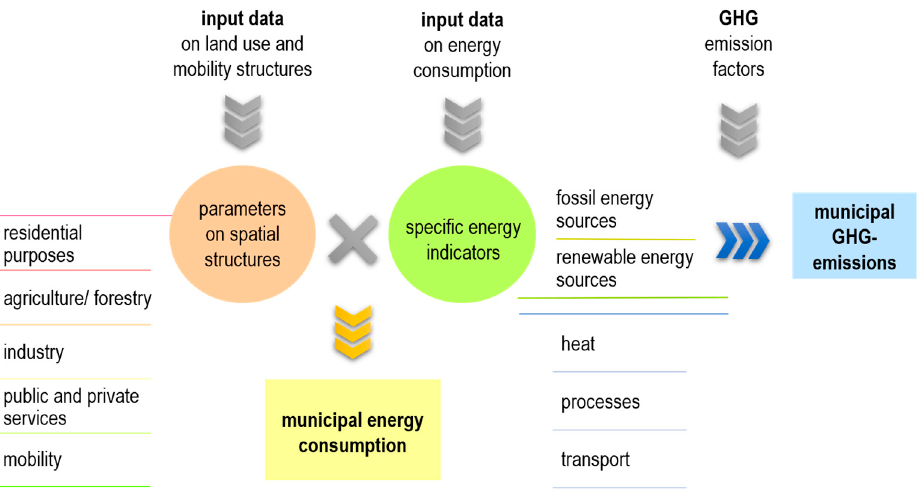
Figure 1. The approach of the energy mosaic Austria.